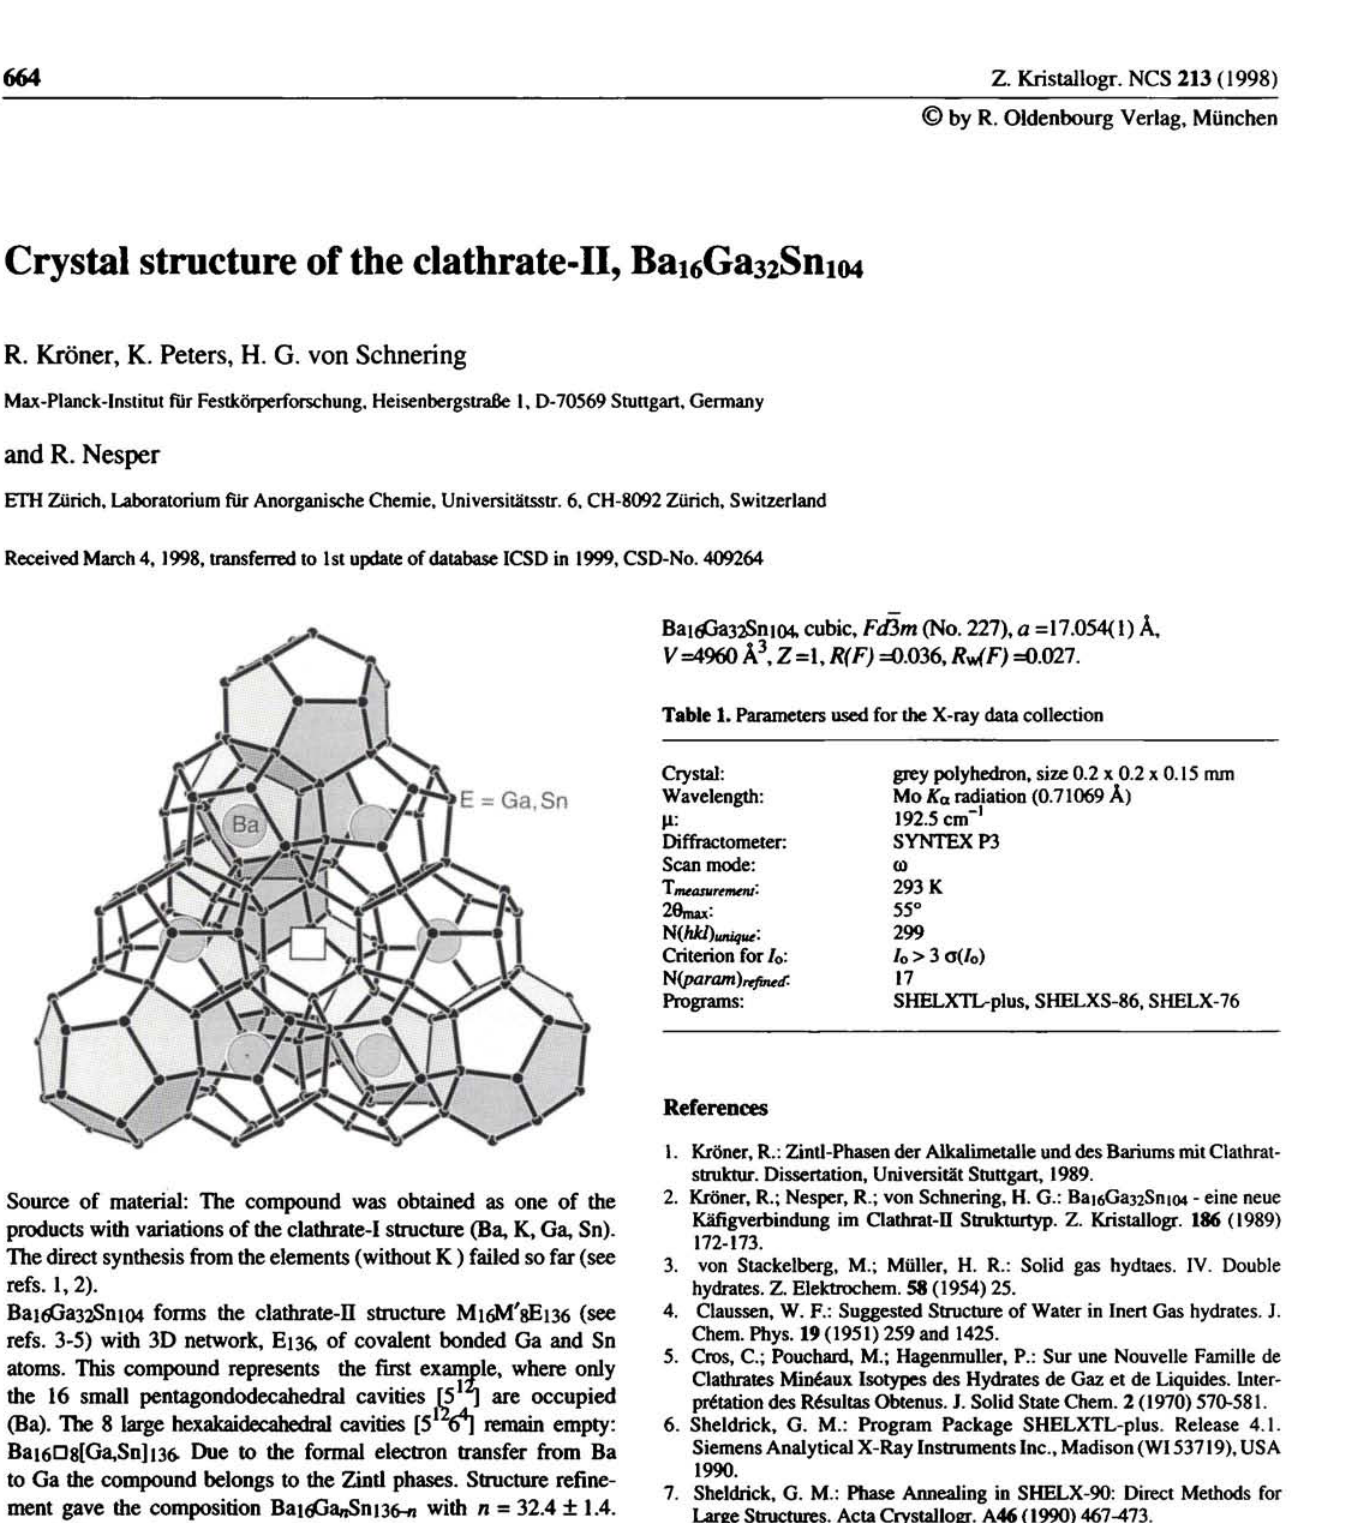
Table 2. Final atomic coordinates and displacement parameters (in Â^)